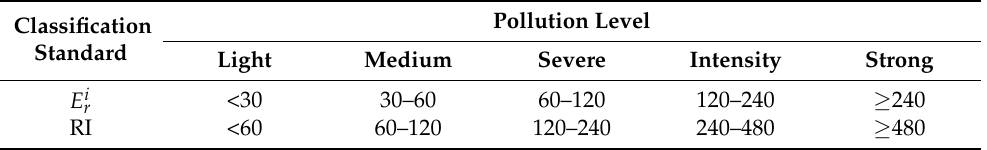
Table 4. Classification standard for ecological risk assessment of heavy metals in